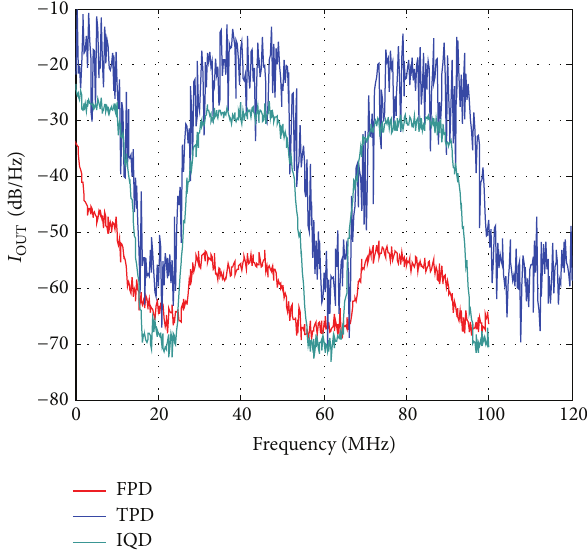
Figure10:EVMversusRFinputpoweroftwo100kHz0.35SQRRC- filtered QPSK modulated carriers @2.4 GHz and 2.8 GHz for FPD, TPD, and